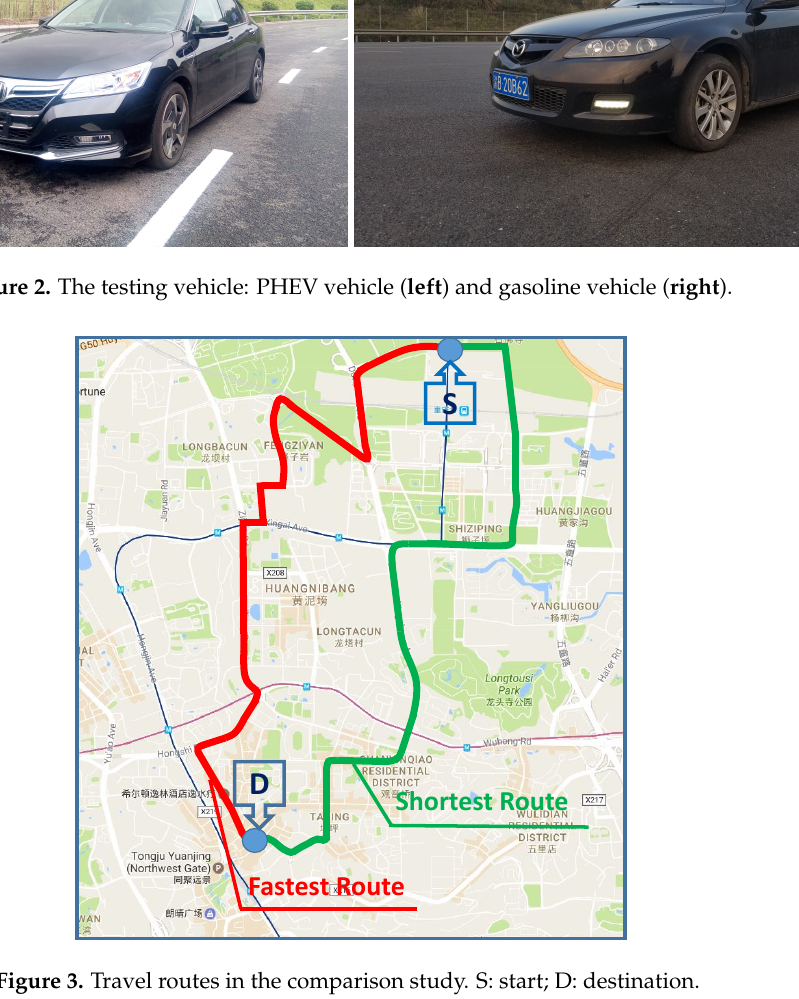
Figure 3. Travel routes in the comparison study. S: start; D: destination.